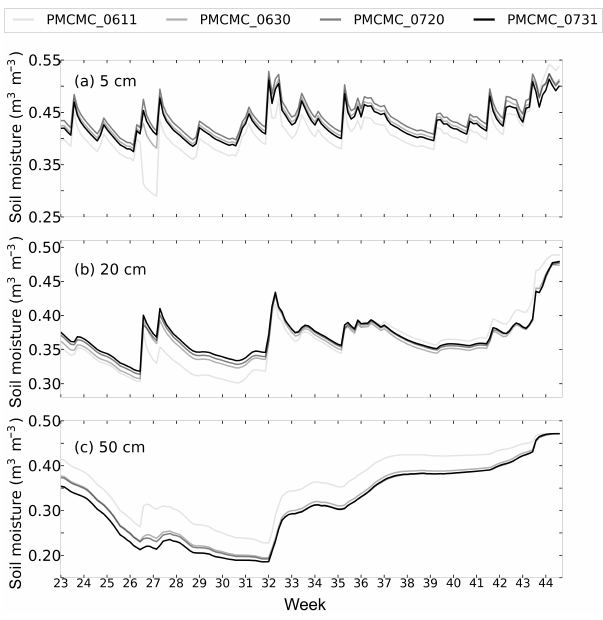
Figure 7. Evaluation period: VIC-3L simulated volumetric mois- ture contents at (a) 5cm, (b) 20cm, and (c) 50cm depths in the soil of the Rollesbroich experimental test site using parameter values de- rived from PMCMC via assimilation periods ending on 6–11 (plat- inum), 6–30 (silver), 7–20 (grey), and 7–31 (black), respectively. For PMCMC_0611, PMCMC_0630, and PMCMC_0720, the soil moisture state on 1 August 2012, the first day of the 5-month eval- uation period, was derived from VIC-3L simulation using the anal- ysis state and parameter values of the last day of the assimilation